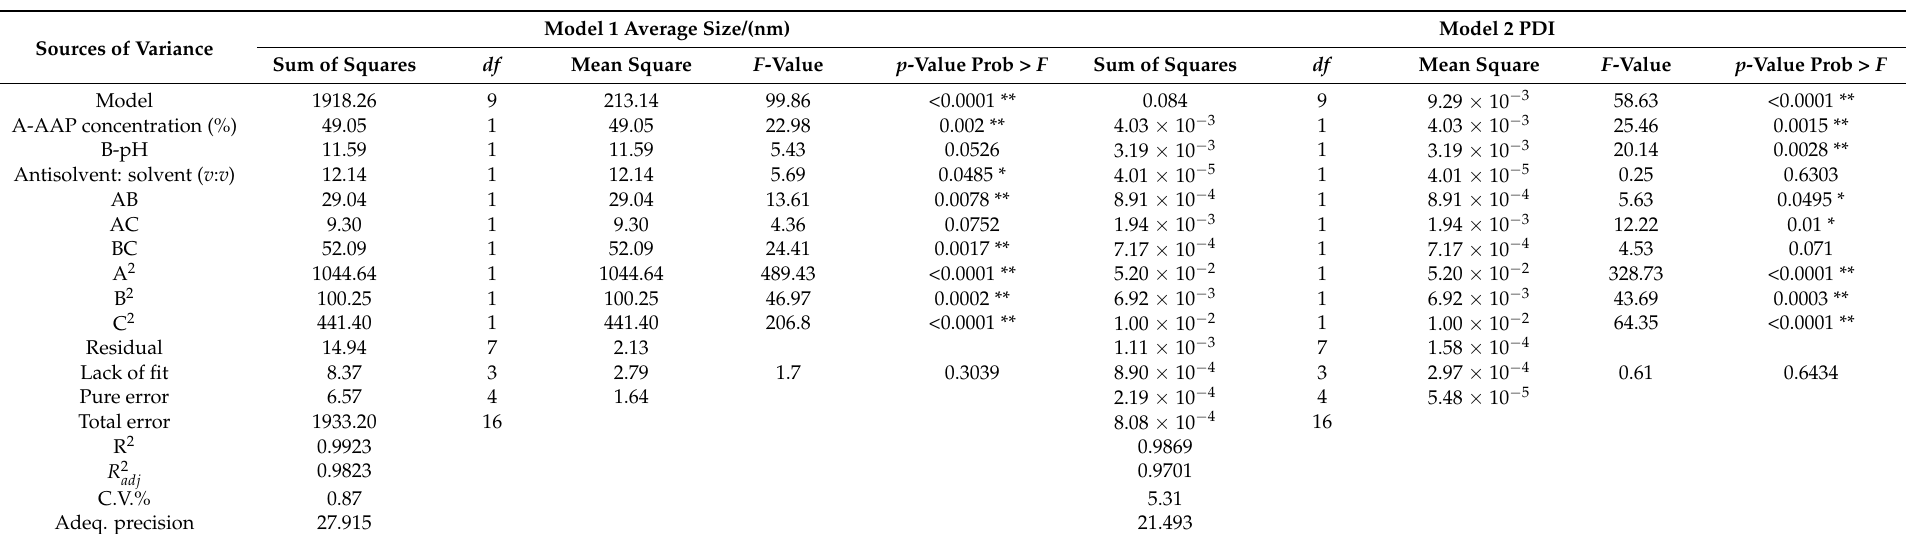
Table 2. Variance analysis results of regression